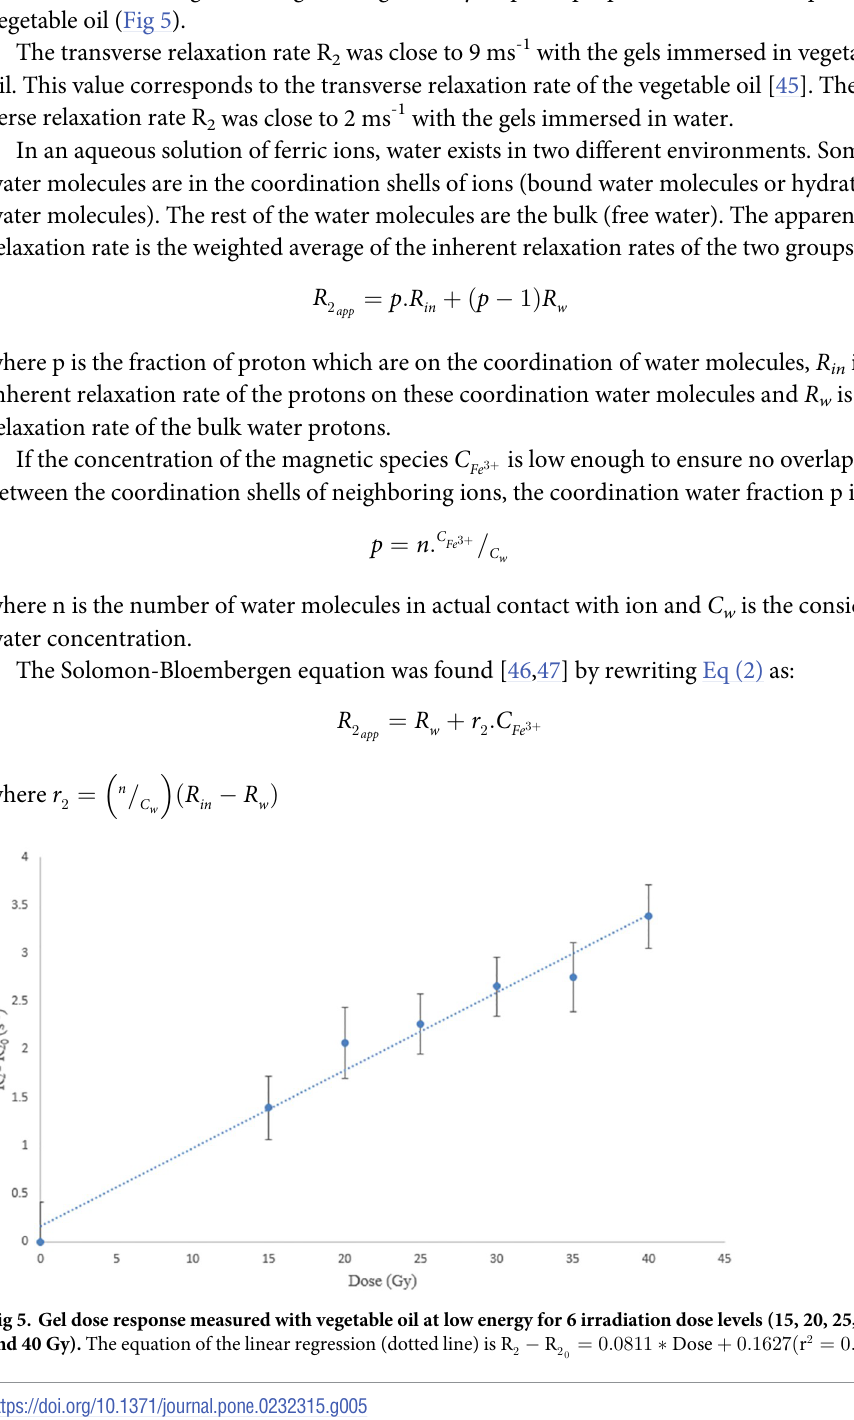
(cid:0) R ¼ 0 : 0811 � Dose þ 0 : 1627 ð r 2 ¼ 0 : 9757 Þ . 2 2 0